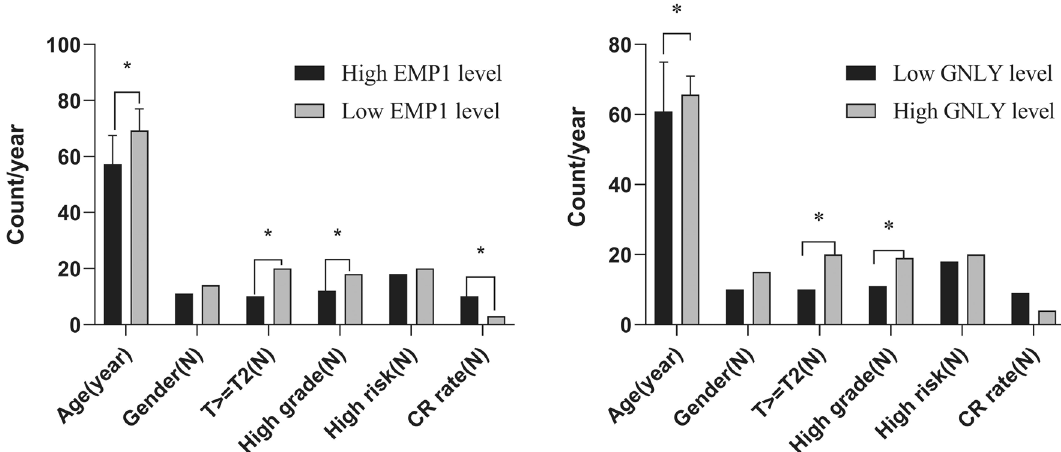
Figure 7. Validation of selected genes of FerroScore in clinical samples. High EMP1 level, contributing to high FerrScore was associated with advanced T stage, high grade tumor and lower CR rate. While, low GNLY level, contributing to high FerrScore was associated with more aged patients, advanced T stage, high grade tumor and lower OR rate. (N: couts for male gender, T > T2, high grade, high risk and omplete response patients